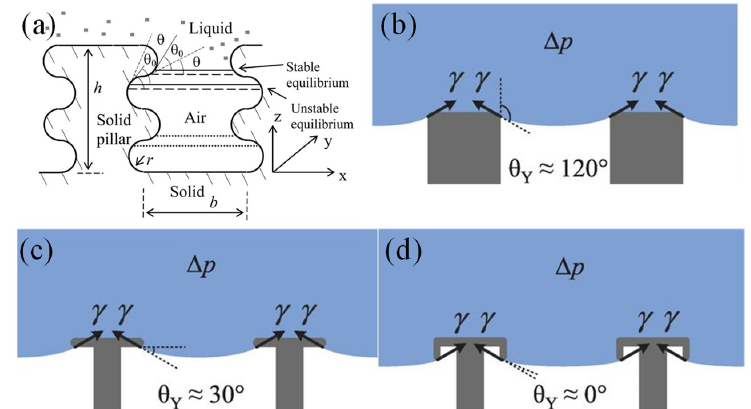
Figure 5. Liquid‐solid contact angle required for stable liquid suspension on ( a ) Surfaces with both semicircular bumps and grooves. Reproduced with permission from [70], published by ACS Publications, 2007. ( b ) micro‐pillar structures, ( c ) re‐entrant structures, ( d ) doubly re‐entrant structures. Reproduced with permission from [67], published by Science, 2014.